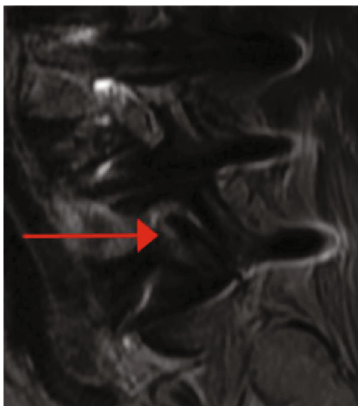
Figure 5: Postoperative sagittal T2 MRI demonstrating persistent L5 nerve compression in the L5-S1 foramen (arrow).